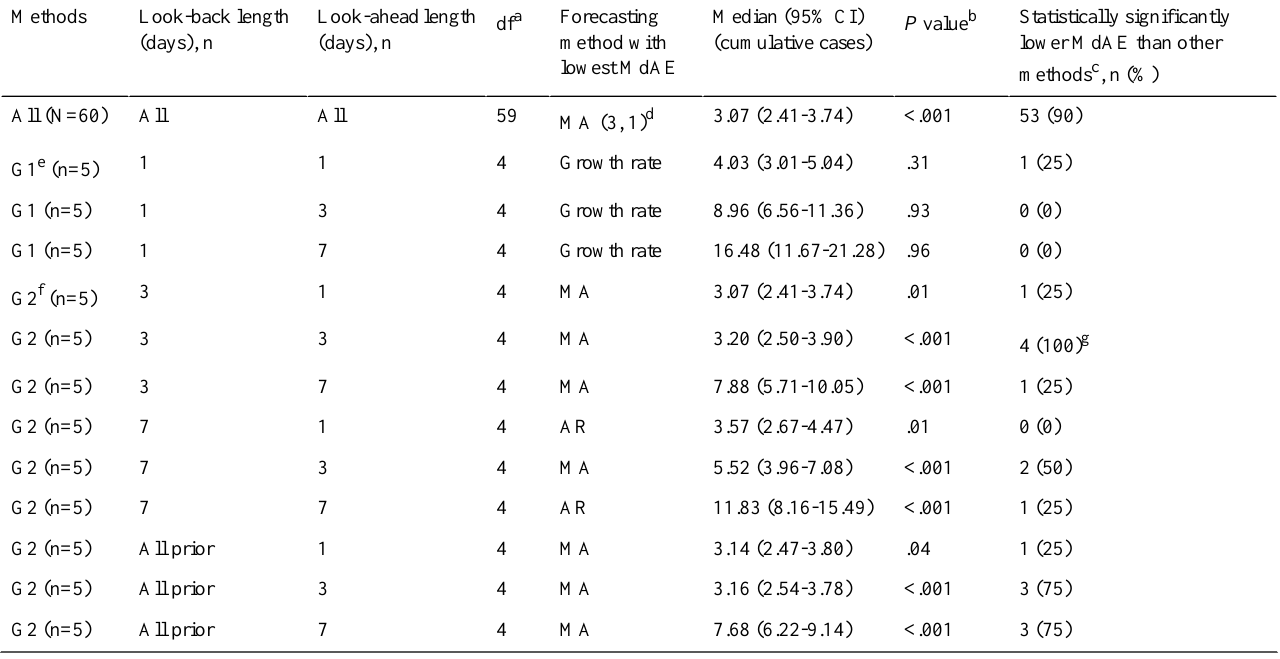
Table 2. Health district–level median absolute error (MdAE) outcomes by forecasting method, look-back length, and forecast